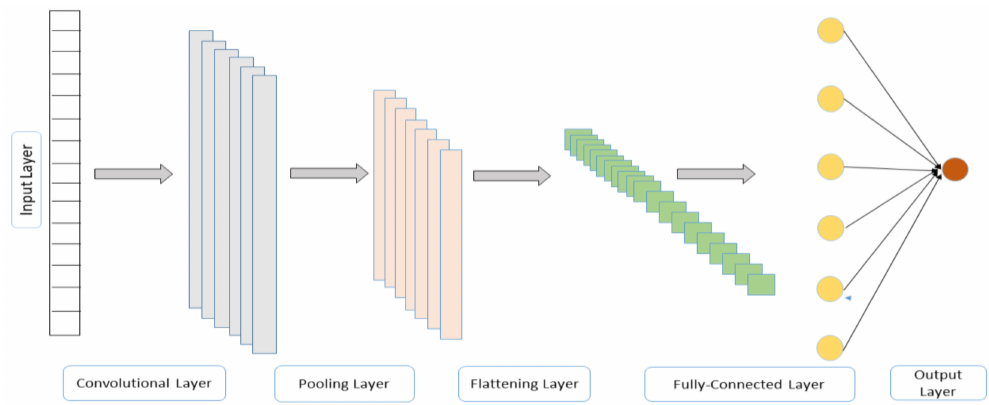
Figure 3. Representation of a CNN